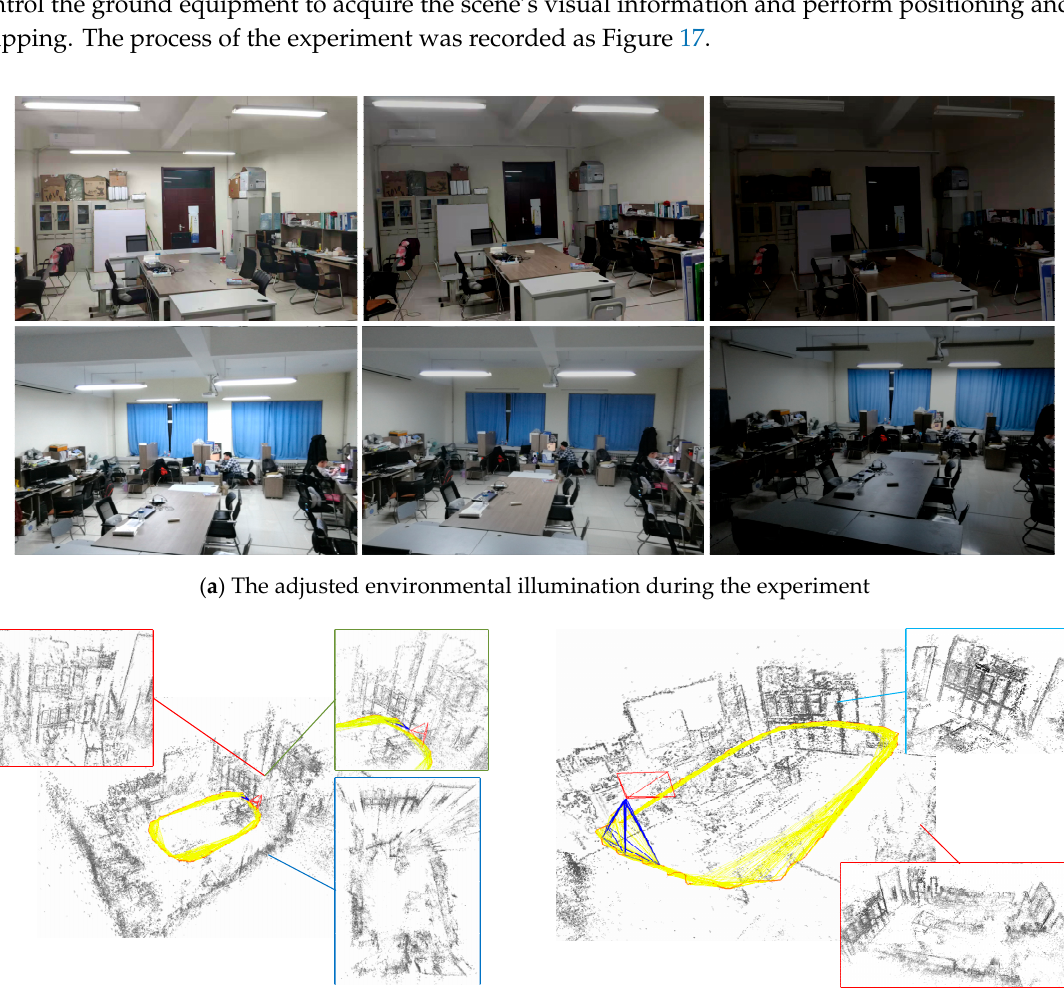
Figure 16. The camera and notebook were installed on the mobile ground equipment. Then, the camera was calibrated using a checkerboard to eliminate radial distortion.